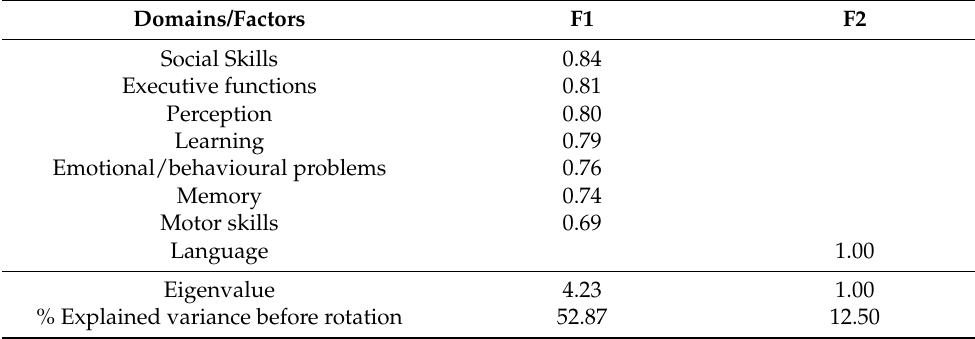
Table 4. FTF Questionnaire Structure Matrix of Factorial Saturations.